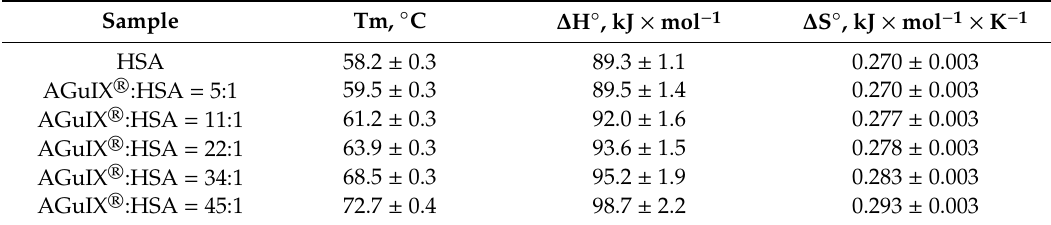
Table 1. Values of the melting temperatures (Tm), enthalpy variations ( ∆ H ◦ ) and entropy variations ( ∆ S ◦ ) of HSA and AGuIX ® -HSA complexes with di ff erent AGuIX ® concentrations (from the SRCD measurements at 192